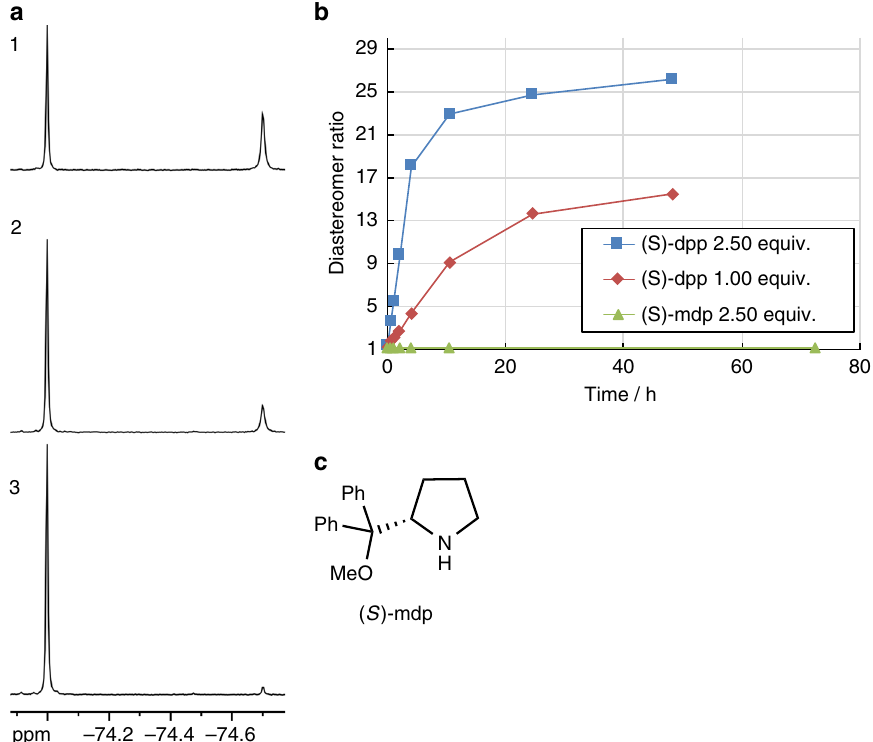
Fig. 4 Process of the dynamic asymmetric induction in [ZnL(( S )-dpp)]. a 19 F NMR spectra (C 6 D 6 , 300 K, 471 MHz) for the time-course analysis for the formation of ( S Zn )-[Zn L (( S )-dpp)]. Conditions: rac -[Zn 2 L 2 ] + ( S )-dpp (2.50 equiv.); dry MS4A; C 6 D 6 ; 4.00 mM; 70 °C; (1) 0 h, (2) 0.5 h, (3) 48 h. b Time- course variation of diastereomeric excess calculated from 19 F NMR in various conditions. Conditions: rac -[Zn 2 L 2 ] + ( S )-dpp or ( S )-mdp (2.50 or 1.00